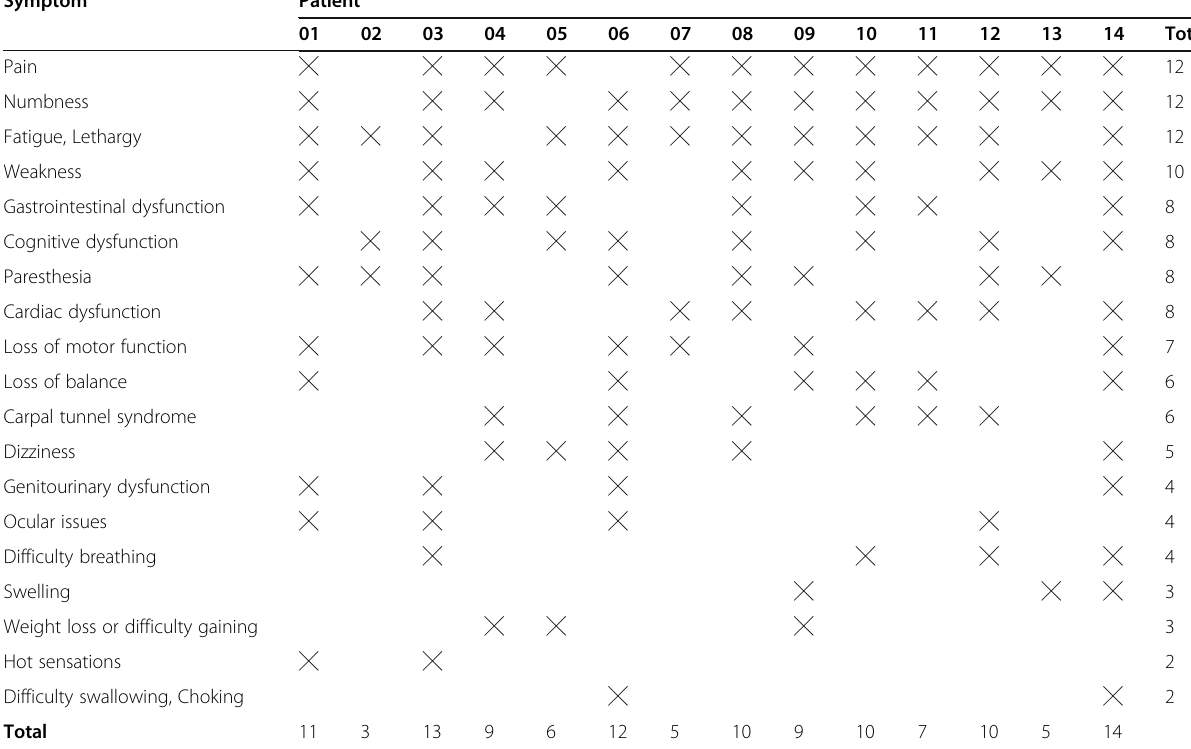
Table 3 Signs and Symptoms Associated with hATTR Amyloidosis Symptom a Patient b